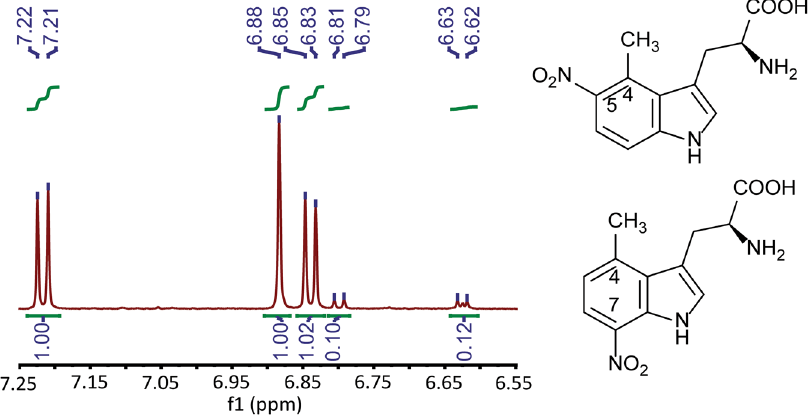
Figure 4. Both 4-Me-5-NO 2 -l-Trp and 4-Me-7-NO 2 -l-Trp were produced in the TB14 reaction with 4-Me-dl- Trp as substrate. The aromatic region of 1 H NMR spectrum of isolated product showed the chemical shifts of two sets of aromatic protons. Integrated values of these protons were also